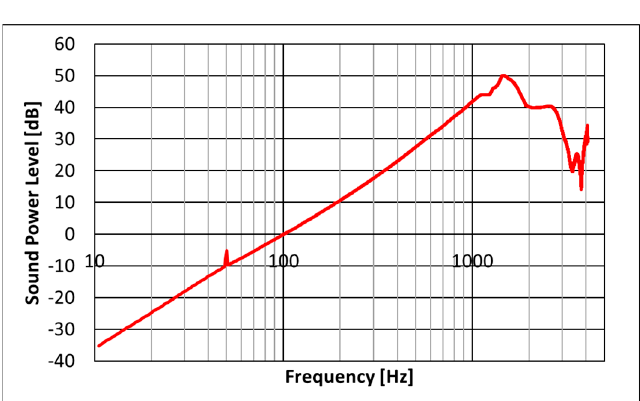
Figure 6. Sound Power Level [dB] emitted by the LMS “Q source”.